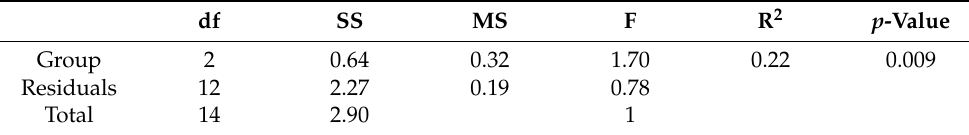
Figure 3. ( a ) Fish species composition in different segments; ( b ) Heat map of fish composition based on relative sequence abundance at each sample site. Table 3. PERMANOVA on fish composition in different section data sets.